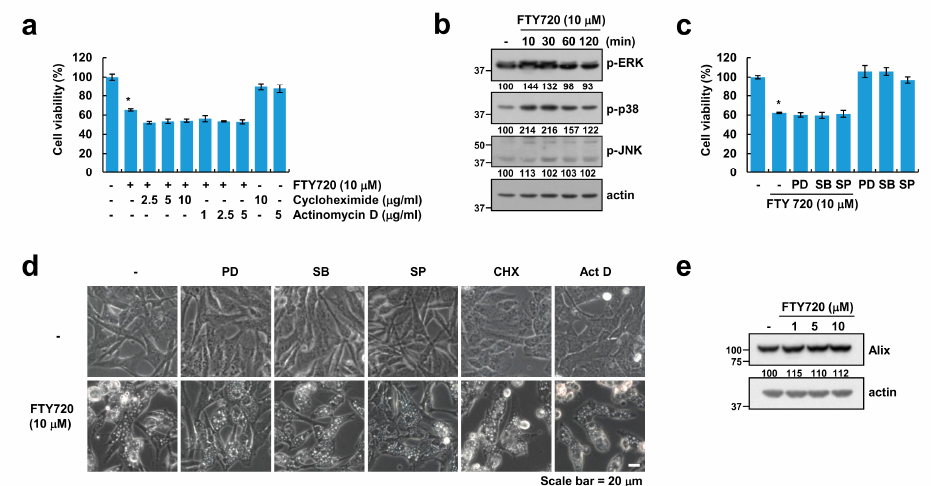
Figure 3. FTY720-induced cell death is independent of paraptosis in human glioma cells. ( a ) U251MG cells were pretreated with the indicated concentrations of cycloheximide or actinomycin D for 30 min, and then treated with 10 µ M FTY720 for 24 h. ( b ) U251MG cells were treated with 10 µ M FTY720 for the indicated time periods. ( c , d ) U251MG cells were pretreated with MAPK inhibitors [ERK inhibitor: 50 µ M PD98059 (PD); p38 MAPK inhibitor: 10 µ M SB203580 (SB); and JNK inhibitor: 10 µ M SP600125 (SP)] for 30 min, and then treated with 10 µ M FTY720 for 24 h. ( e ) U251MG cells were treated with